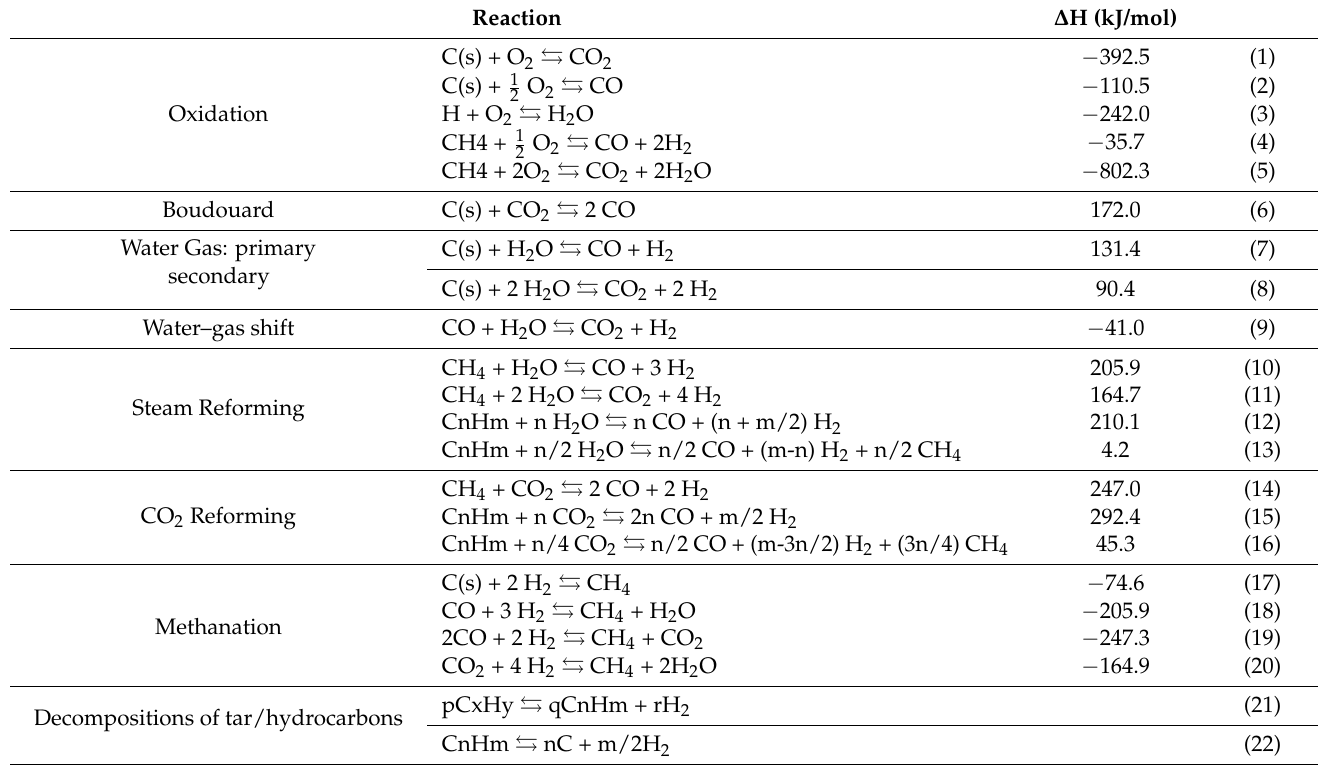
Table 1. Main gasification reactions